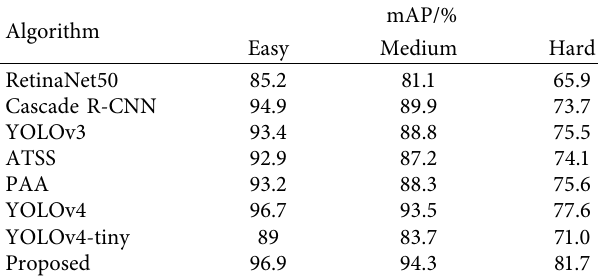
Figure 7: Detection results on the WIDERFACE set. (a) Light change. (b) Dense small faces. (c) Fuzzy scene. (d) Blocking faces. Table 4: Comparative results